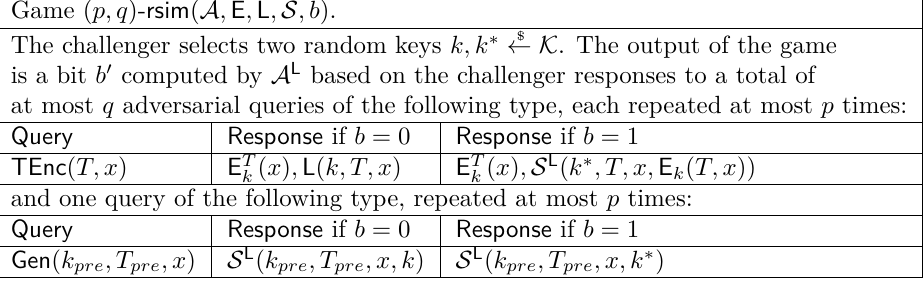
Table 2: The ( p, q )- rsim -game for